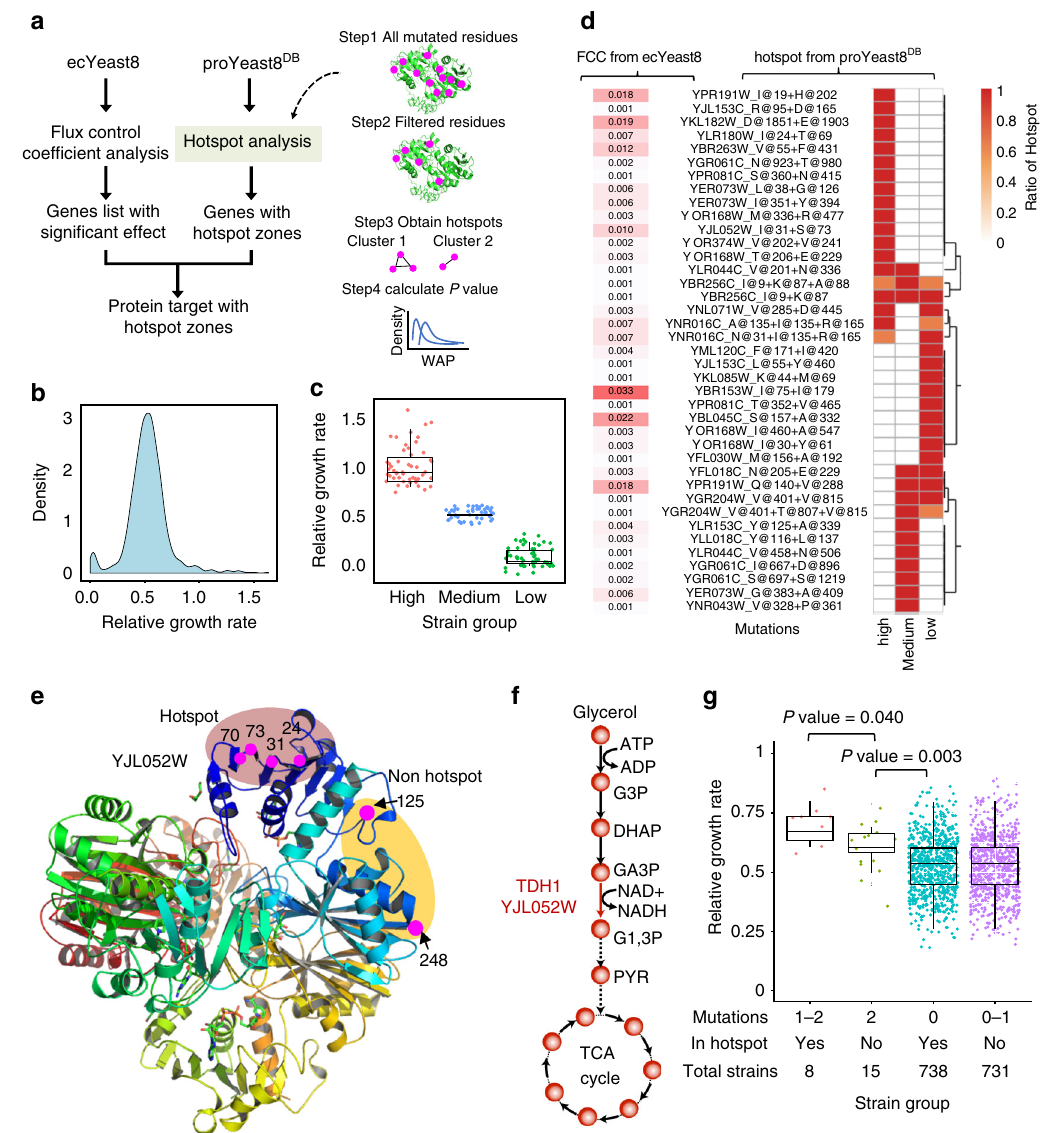
Fig. 5 Systematic analysis of ecYeast8 and proYeast8 DB underlies the potential relations between gene mutations and growth phenotype. a Pipeline to conduct the integrative analysis of ecYeast8 and proYeast8 DB . b Distribution of relative growth rate with glycerol as carbon substrate in complex medium. c Three groups of strains with high, medium and low relative growth rates used for hotspot analysis. d Heatmap of hotspot zones for three groups of strains and heatmap of fl ux control coef fi cients obtained from ecYeast8 with growth as the objective function. e Mapping of all YJL052W mutations from strains with high growth rate onto the protein 3D structure. f Position of enzyme encoded by YJL052W in the glycerol utilisation pathway. g Classi fi cation of the remaining strains based on mutations in hotspot zones and non-hotspot zones of YJL052W. The statistical analysis is based on Wilcoxon rank sum